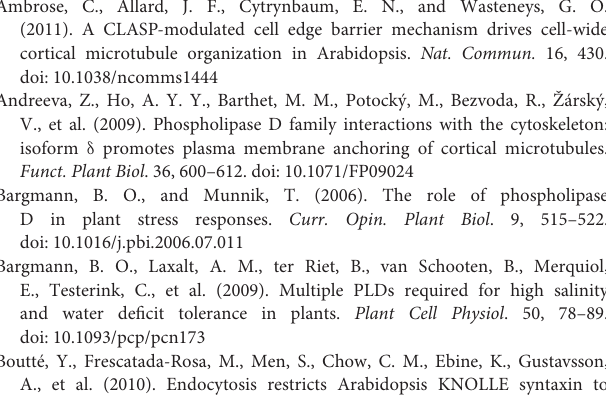
Figure S1 | Comparison of PLD α 1-YFP localization in different aerial organs and tissues of pld α 1-1 (A–E) and pld α 1-2 (F–J) mutants stably expressing PLD α 1-YFP driven by its own promoter: epidermis of first true leaf (A,F) , epidermal cells of hypocotyl (B,G) , epidermal cells of cotyledon petiole (C,H) , epidermal cells of cotyledon (D,I) and entire 5 days-old seedling (E,J) . Figure S2 | PLD α 1-YFP localization in different tissues of the root tip of rescued pld α 1-1 mutant stably transformed with proPLD α 1::PLD α 1:YFP construct by light-sheet fluorescence microscopy. (A) Localization of PLD α 1-YFP in cells of the root tip counterstained by propidium iodide and merged image. Profiles at different